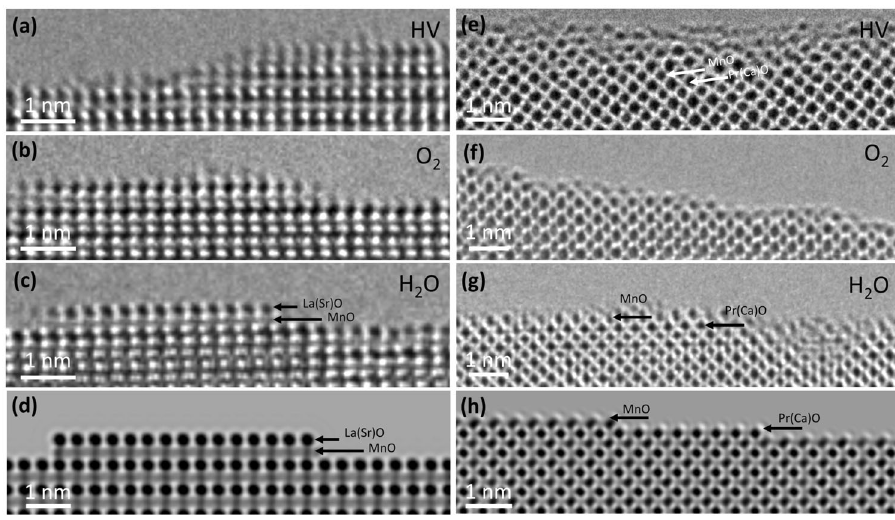
Fig. 2 HRTEM cross plane images of LSMO and PCMO (001) surfaces in different ambients. All images are taken at negative defocus, i.e., atomic columns appear as dark contrast, and with objective lens aberrations corrected up to 5th order. a – d LSMO is imaged in the pseudocubic [110] zone axis. a Mixed B- and A- termination in high vacuum (HV). b Dominant A-termination in 1 mbar O 2 . c In 0.5 Pa H 2 O, the surface consists of a stable A-layer with highly mobile Mn on top (see Fig. 3). d Simulated image with A-termination and surface step. e – h PCMO is imaged in the orthorhombic [110] zone axis. e Disordered surface structure in HV. f Highly ordered surface in 1 mbar of O 2 with a mixed termination. g In 0.5 Pa of H 2 O, the B-terminated areas of PCMO exhibit pronounced disorder with mobile Mn. h Simulated image for PCMO with different surface terminations.